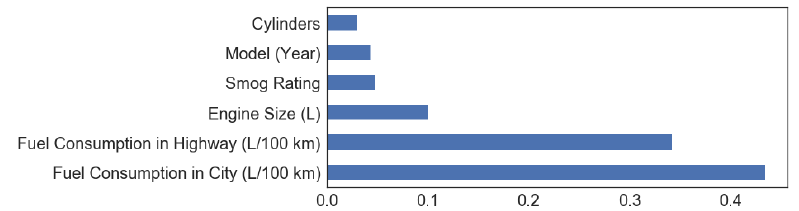
Figure 13. Importance of features on predicting total fuel